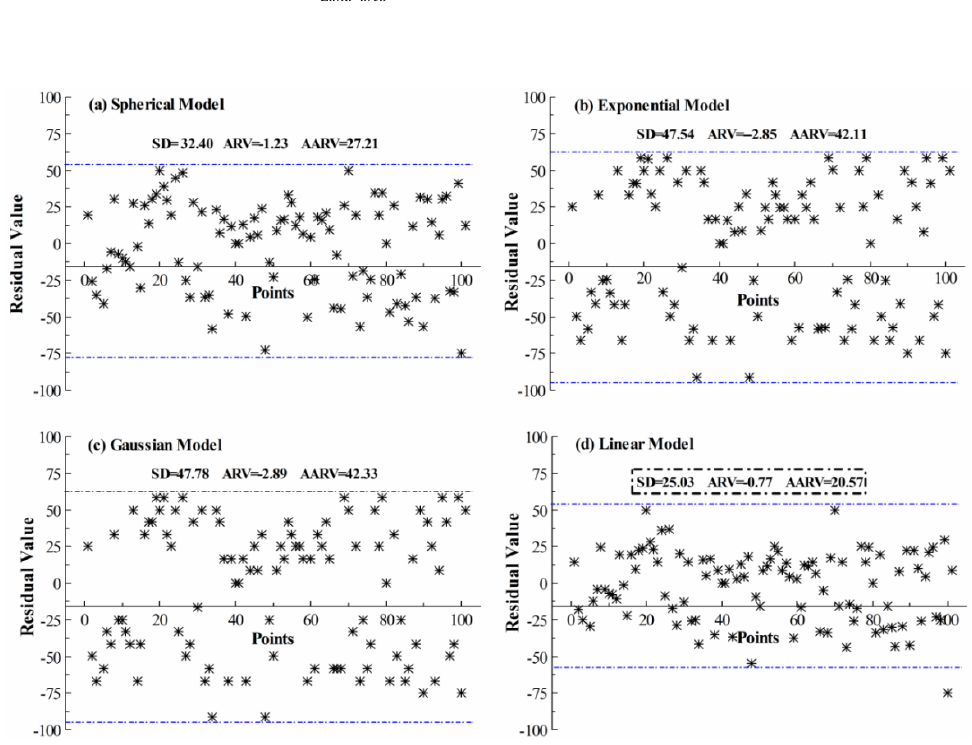
Figure 13. Residual value of different Kriging interpolation modes: standard deviation (SD), average residual value (ARV), and average of absolute residual value (AARV). ( a ) Spherical Model; ( b ) Exponential Model; ( c ) Gaussian Model; ( d ) Linear Model.